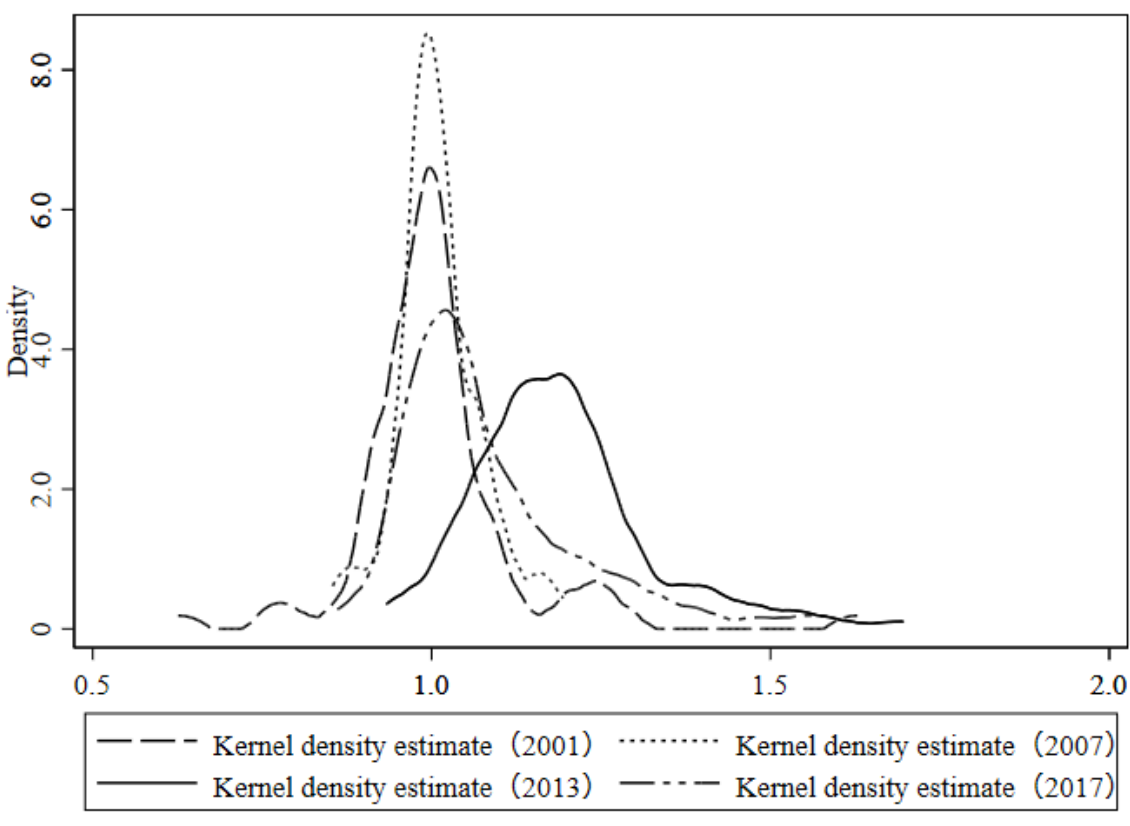
Figure 3. Distribution of GTFP of grain kernel density in representative years.